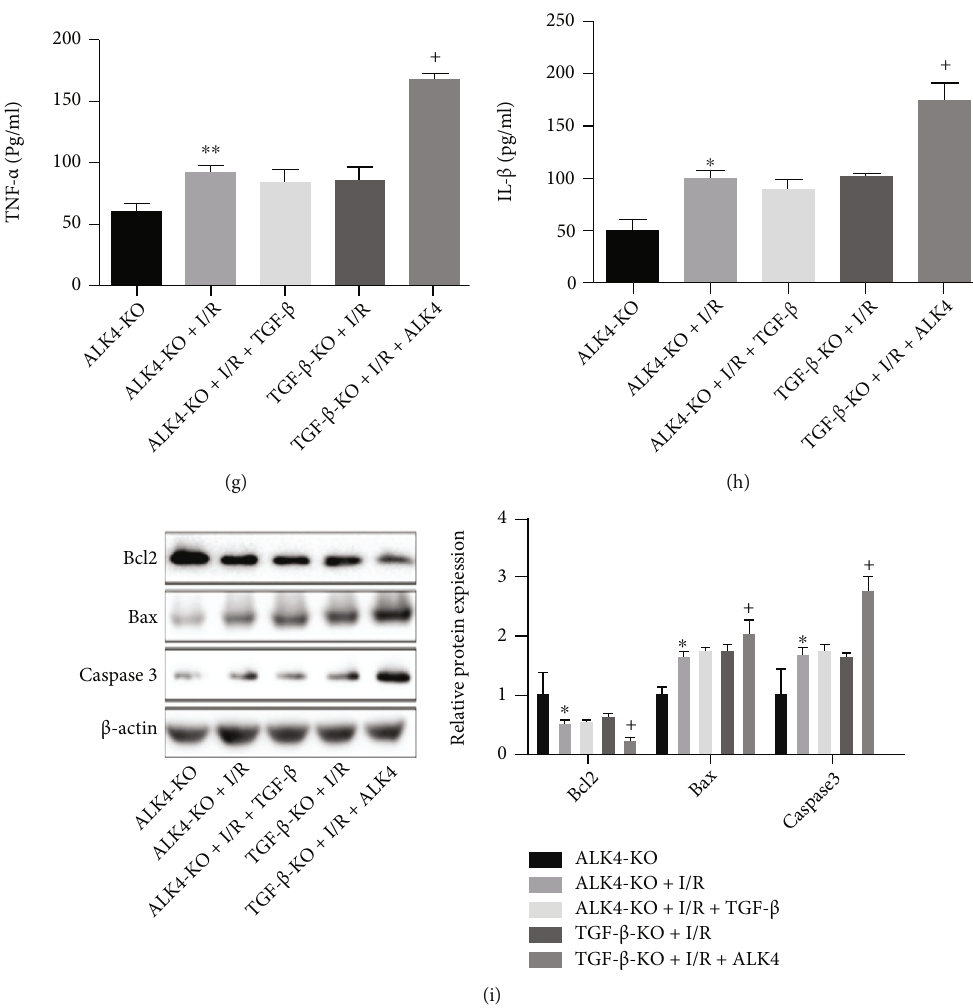
Figure 7: Knockout of ALK4 in the cell model of hypoxia/reoxygenation while exogenous TGF- β protein treatment. (a – e) Antioxidation indicators SOD, MDA, CK, LDH, and AST, and in fl ammatory response indicators TNF- α , IL-6, and IL-1. (i) WB detection Bcl2, Bax, and